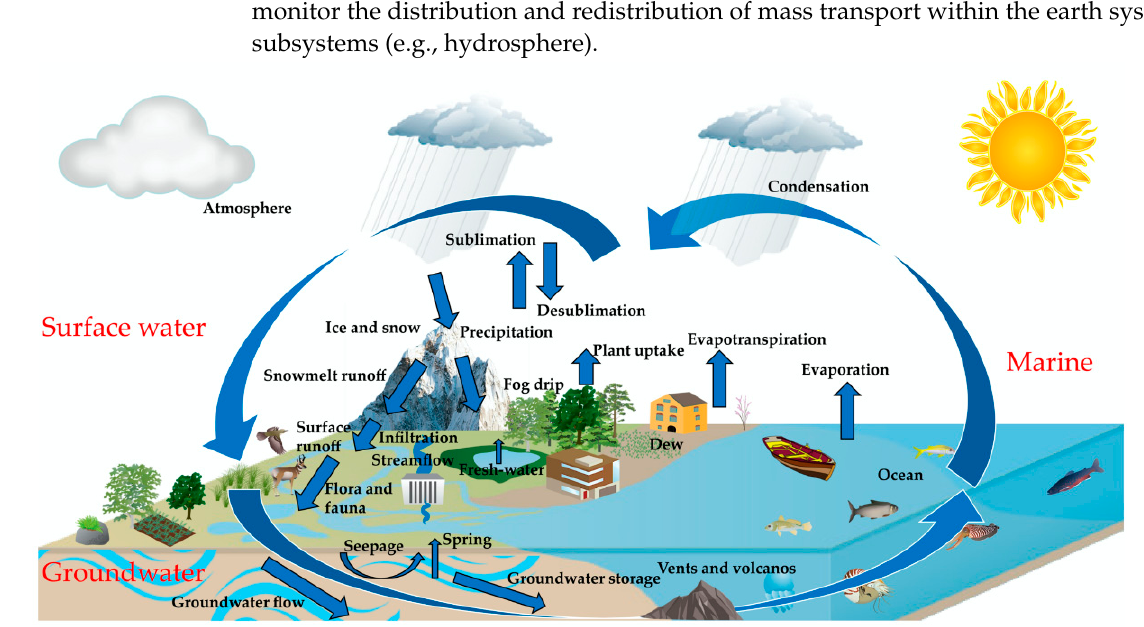
Figure 1. Schematic diagram of the global hydrological cycle and water resources. Geodesy, composed of various observation techniques of the earth’s shape, rotation, and gravity field (and their respective temporal variations), has been playing an important role in sensing meteorological, climatological, and hydrological events. For example, sat- ellite gravimetry, represented by the Gravity Recovery and Climate Experiment (GRACE) and its follow-up mission (GRACE-FO), has been a unique means to monitor the distribu- tion and redistribution of mass transport within the earth system and subsystems (e.g., hydrosphere).